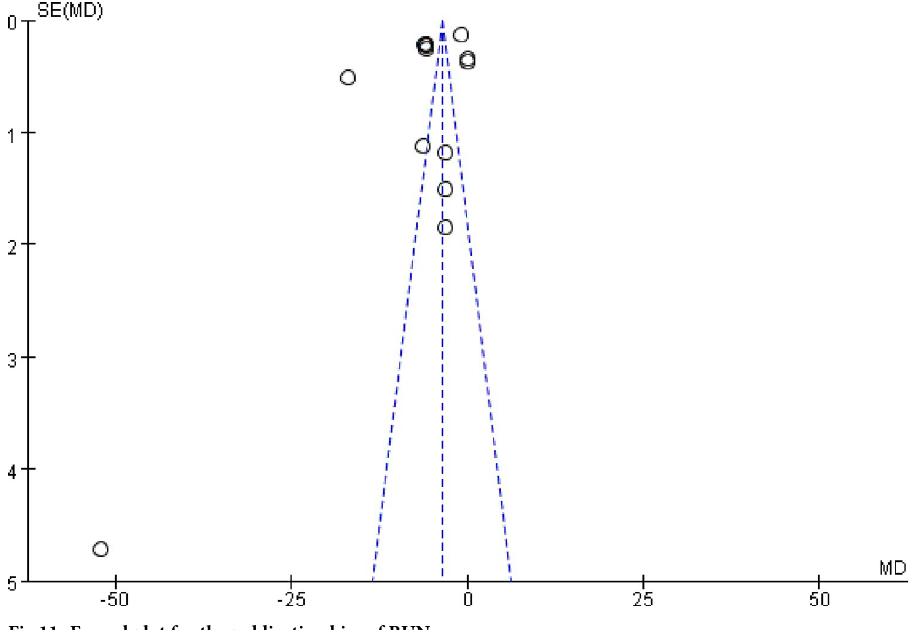
Fig 11. Funnel plot for the publication bias of BUN.